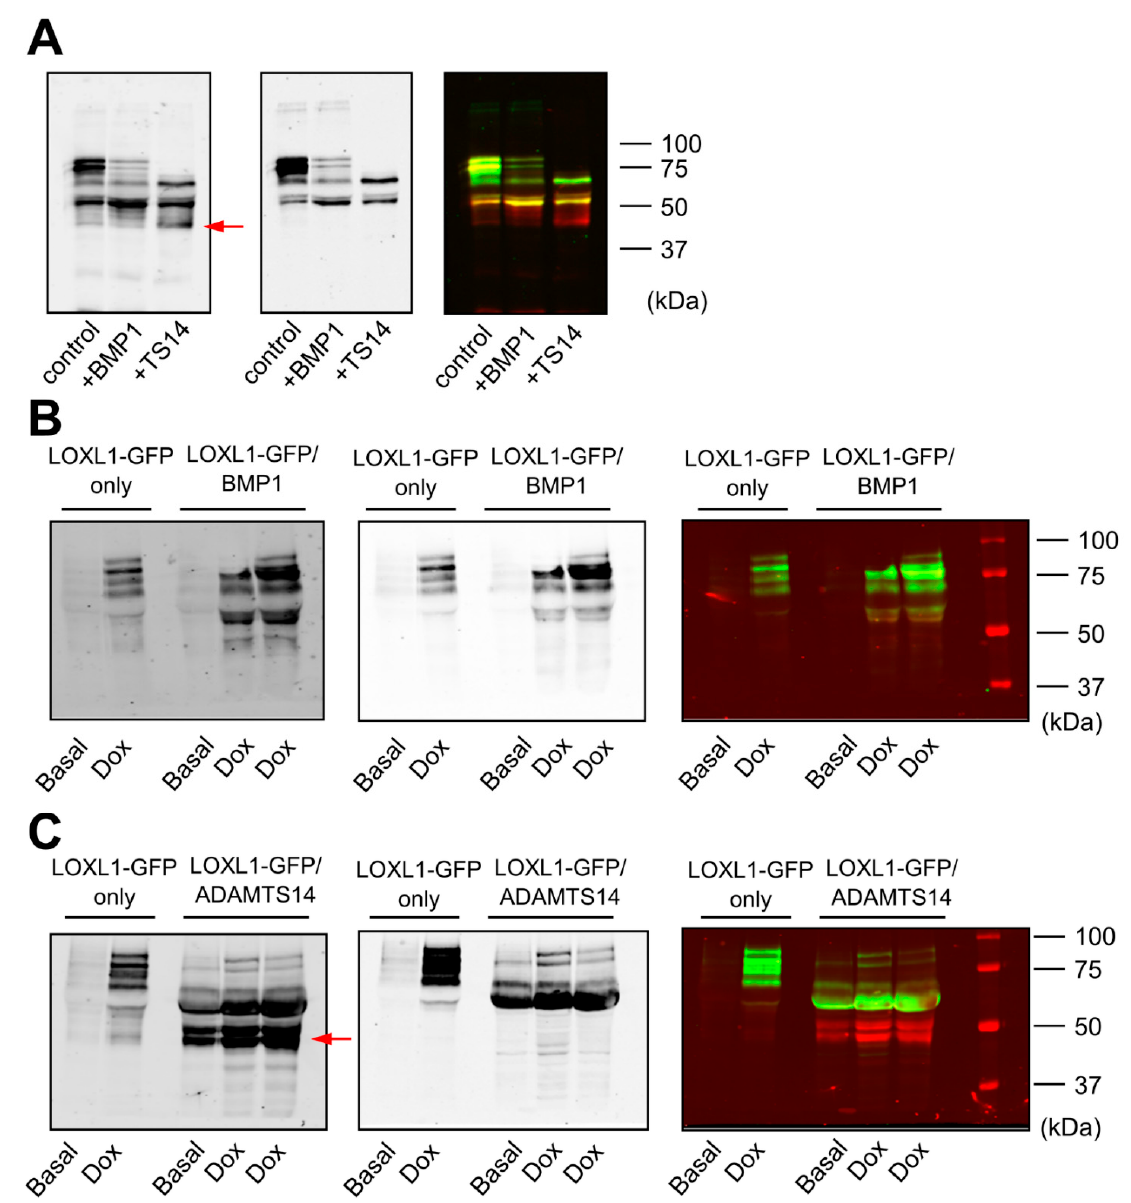
Figure 2. Cleavage of LOXL1-GFP by BMP1 and ADAMTS14. LOXL1-GFP cleavage was assayed by Western blotting in in vitro incubation assays ( A ) and co-cultures of LOXL1-GFP/BMP1 ( B ), or LOXL1-GFP/ADAMTS14-overexpressing cells ( C ). For in vitro assays, LOXL1-GFP-containing supernatants were incubated with BMP1 or ADAMTS14 for 2 h at 37 °C. Co-culture experiments were performed by seeding cells in a 50/50 proportion. Upon confluency, cells were left under basal conditions or stimulated with doxycycline for 48 h. Controls for single LOXL1-GFP cultures were also included (LOXL1-GFP only). In vitro reactions or concentrated supernatants from co-cultures were analyzed by Western blotting using anti-LOXL1 and anti-GFP antibodies. Blots showed detection signals for anti-GFP (left panel), anti-LOXL1 (middle panel), and both antibodies together (right panel). Note that proteolysis with ADAMTS14 yielded bands that were only recognized by the anti-GFP antibody (marked by a red arrow in anti-GFP or visualized as red bands in anti-GFP/anti-LOXL1) representing proteolytic products lacking the N-terminal portion of LOXL1. The blots shown correspond to representative experiments performed twice with two independent preparations.